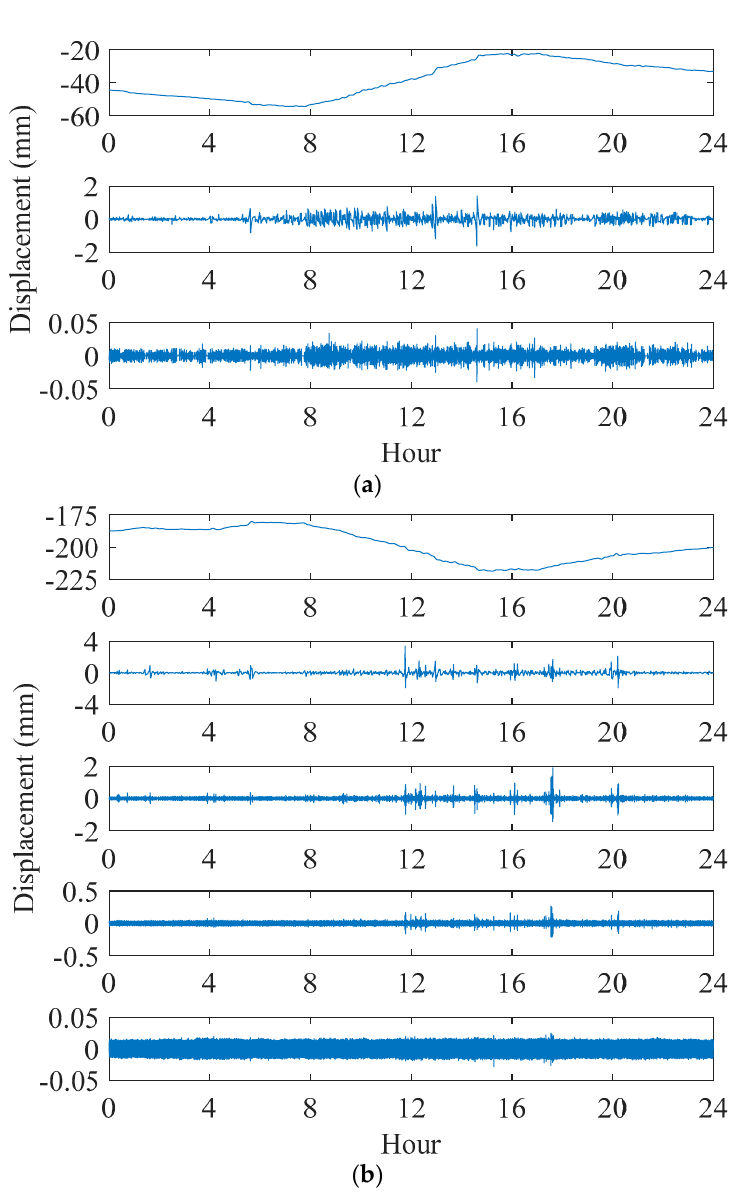
Figure 6. Results of the empirical wavelet transform (EWT) decomposition of the longitudinal displacements at the south girder end over the course of one day: ( a ) bearing (B-7-11); ( b ) expansion joint (EJ-7-1).